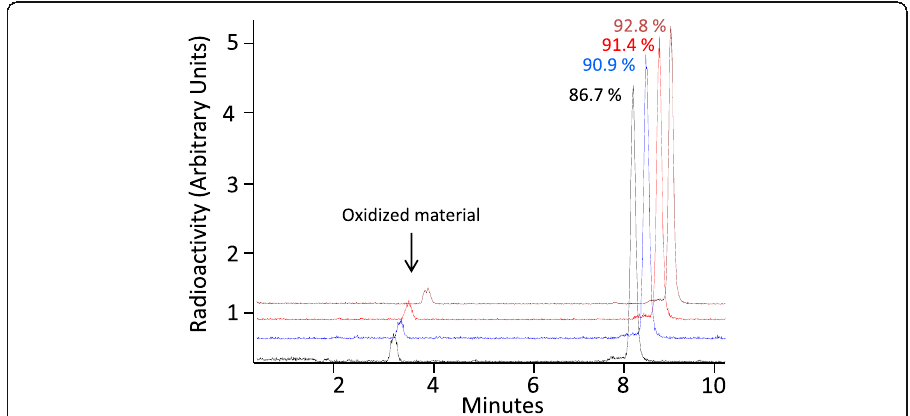
Fig. 2 HPLC radiochemical purity analysis of [ 68 Ga]Ga-DOTA-CP04 with no stabilizers in reactions mixture (black), with L-methionine as the only stabilizer (blue), with L-methionine, EtOH and sodium ascorbate as stabilizers (red) and with L-methionine, EtOH, sodium ascorbate and gentisic acid as stabilizers